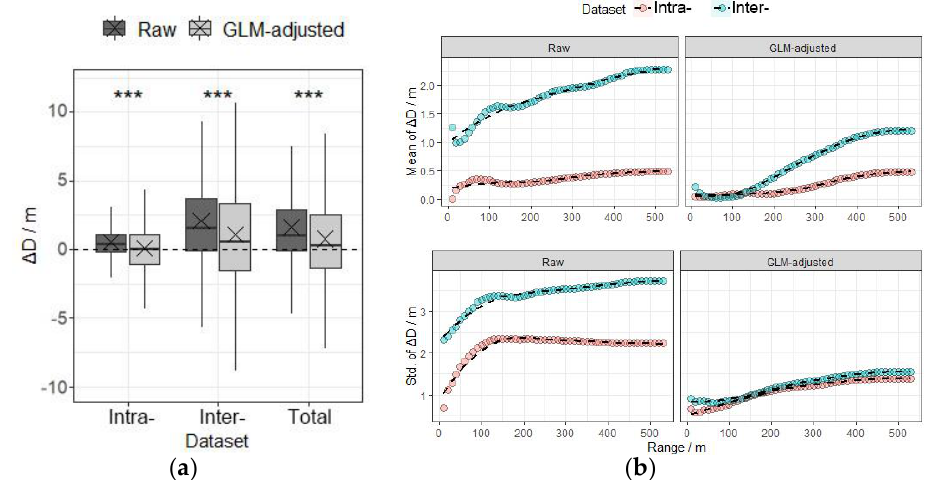
Figure 7. Measurement error of the paired-tree distance ( ∆ D) before and after model correction and spatial accumulation. ( a ) ∆ D between trees based on intra- and inter-point cloud data before and after correction using GLM. “ × ” denotes the mean value and “***” denotes a significant difference according to the one-way analysis of variance ( p < 0.001). ( b ) Differences in the mean and standard deviation of ∆ D as the search radius increased. The black line in the figure is the curve fitted by locally weighted regression.